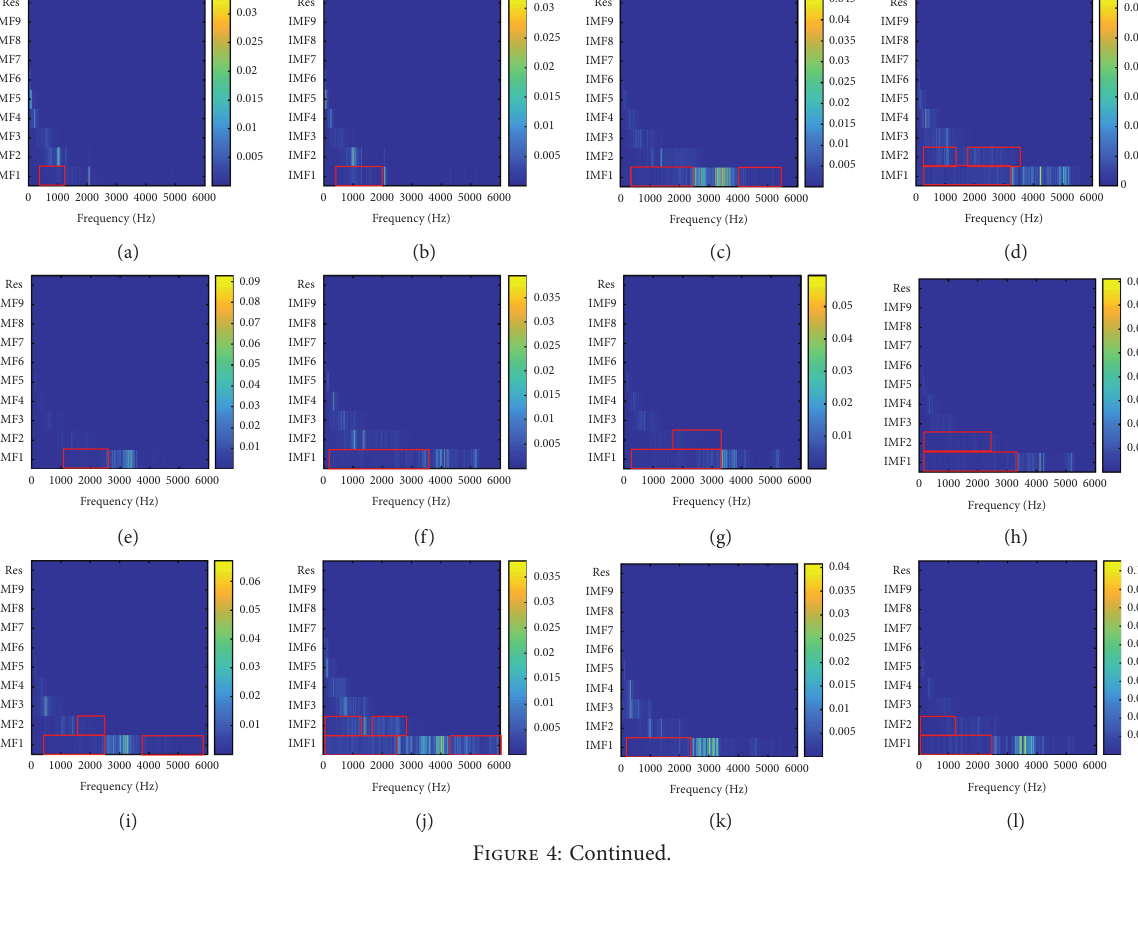
IMF1IMF2IMF3IMF4IMF5IMF6IMF7IMF8IMF9Res